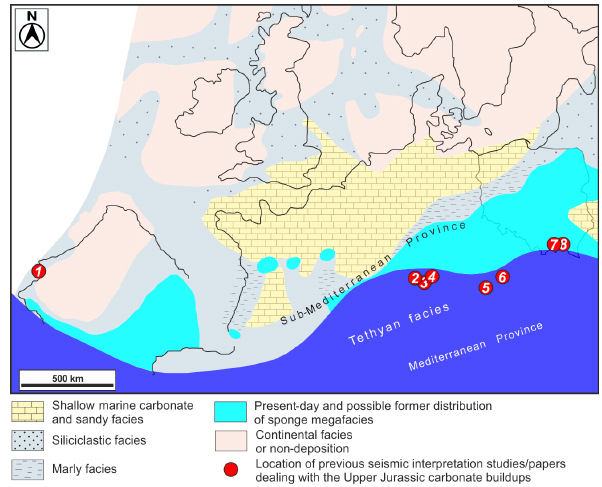
Figure 2. Simplified palaeogeographic sketch map of central and western Europe for the middle–late Oxfordian (based on Wierzbowski et al., 2016); red points show the location of the pre- viously published seismic interpretation studies/papers dealing with the Upper Jurassic carbonate buildups from the northern Tethyan shelf margin and adjacent areas (1. Ellis et al., 1990; 2. Buness